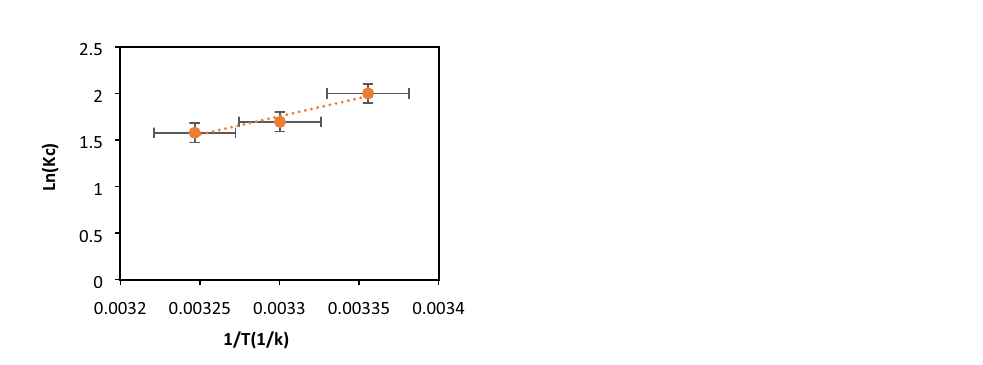
Figure 10. Thermodynamic studies of dye CB biosorption on bean peel